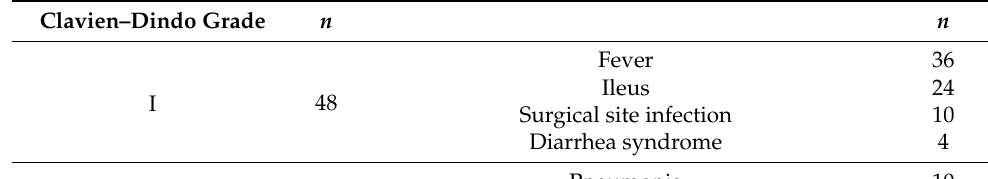
Table 2. Intra-operative and 30-day complications following HR.